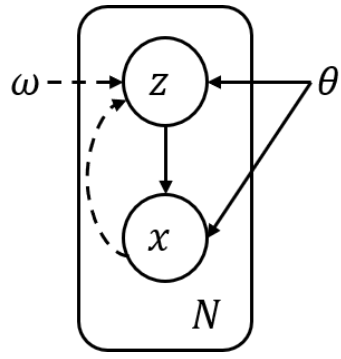
Figure 2. Graph model of VAE.